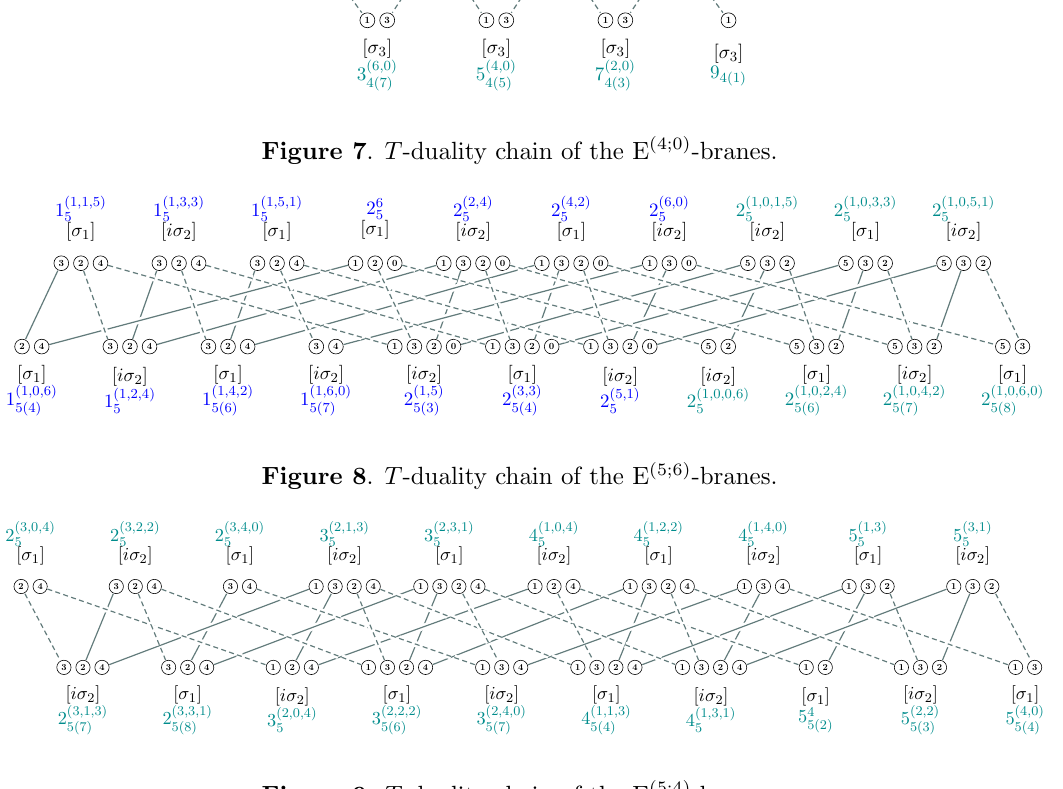
Figure 9 . T -duality chain of the E (5;4) -branes.